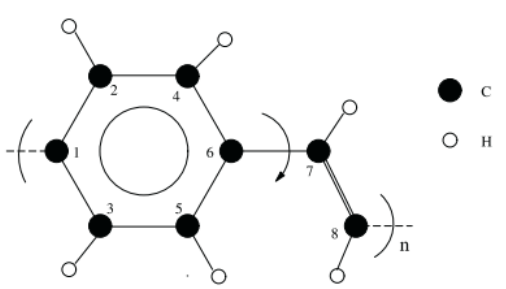
Figure 3. Isolated PPV chain monomer. Numbering is adapted from references [9,54].